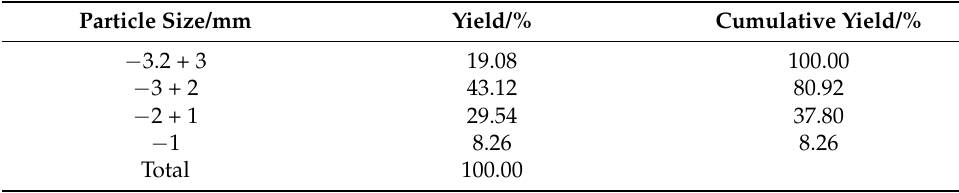
Table 2. The particle size distribution of cassiterite associated with pollimetallic ore. Particle Size/mm